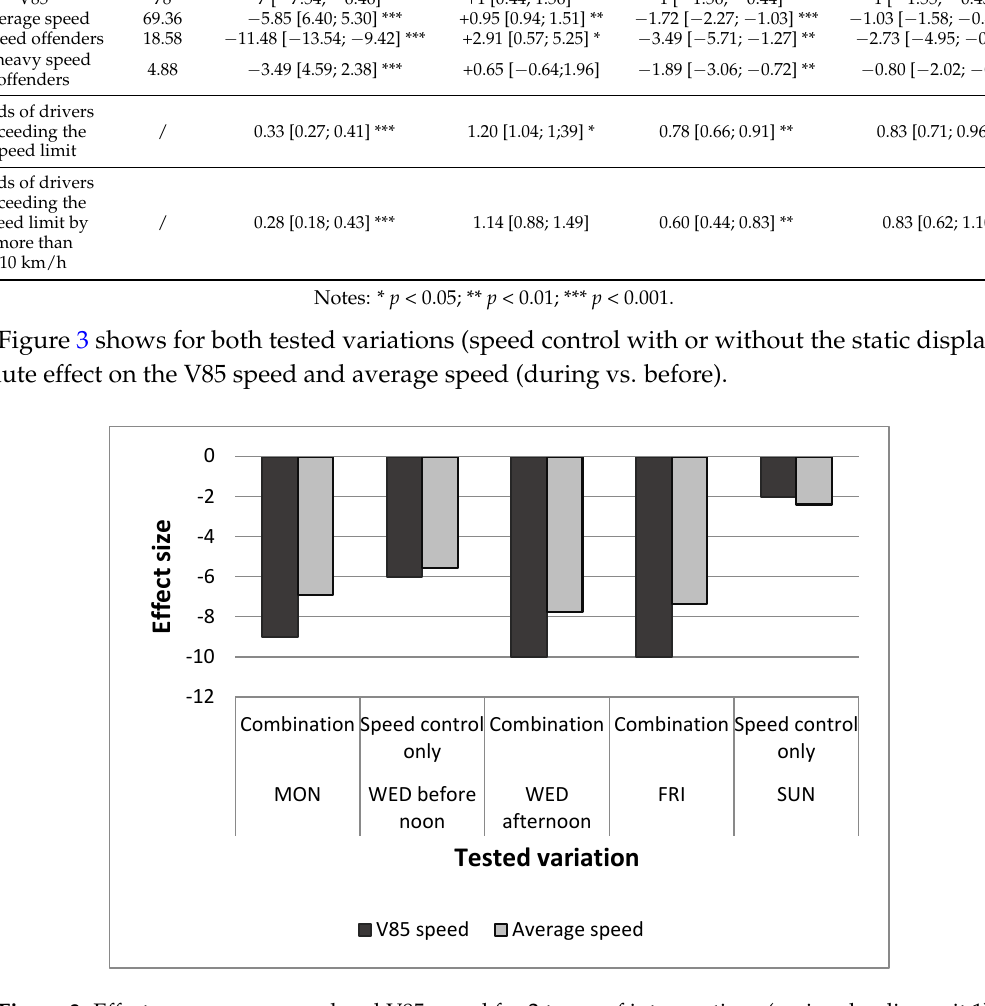
Table 4. Results for the overall effects in regional police unit 2.